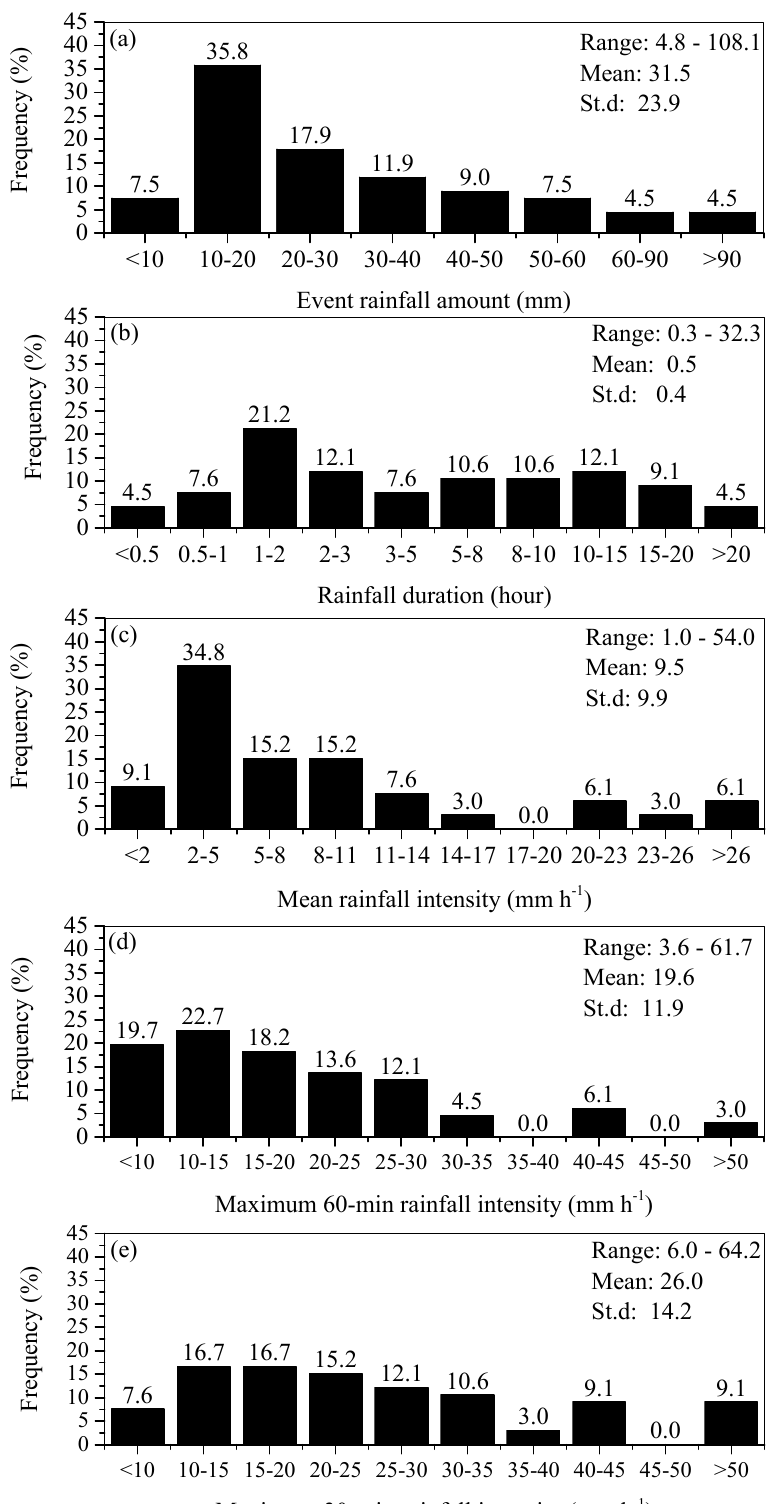
Figure 3. Frequencies of some eigenvalues of the erosive rainfall events between 2014–2020: ( a ) event rainfall amount, ( b ) rainfall duration, ( c ) mean rainfall intensity, ( d ) maximum 60-min rainfall intensity, and ( e ) maximum 30-min rainfall intensity.